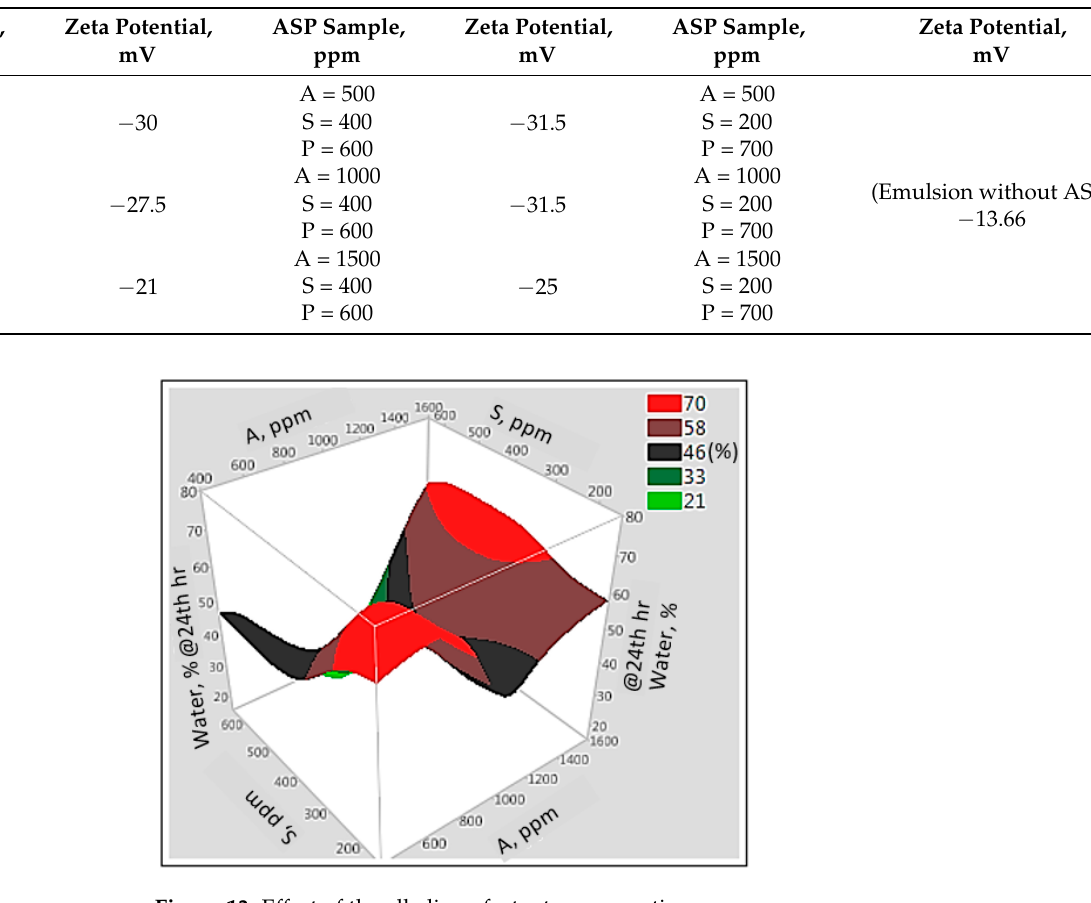
Figure 13. E ff ect of the alkali–surfactant on separation.